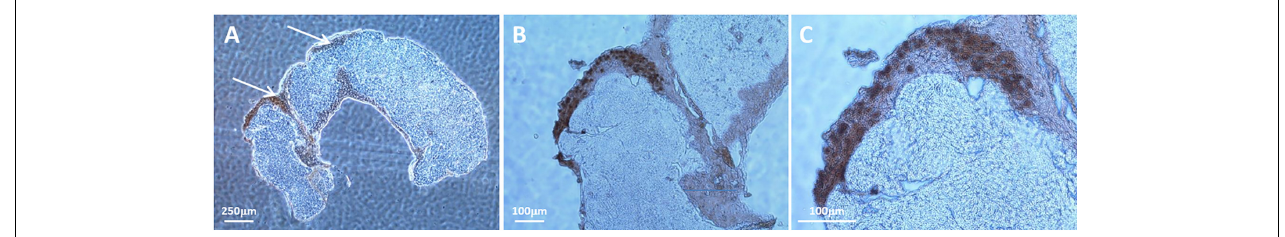
FIGURE 1 | Visualization of a representative VZV-infection within epidermis of human skin explant. Pieces of human skin obtained with a punch that measured 6 mm in diameter were placed in culture medium. As described in Methods, each piece of skin was pierced multiple times with a syringe needle before the infected cell inoculum was layered onto the surface of the same explant. At 14 dpi, infection was analyzed by IHC after labeling with an antibody to a VZV small capsid protein. Since the capsid protein is found mainly in the nuclei of infected cells, the IHC pattern outlined the nuclei within an infectious focus in the SOC epidermis. Two piercing sites in the biopsy are marked with arrows (A) . Enlargements of panel A are shown in panels B,C . The infectious focus contains around 30 nuclei (dark brown color).